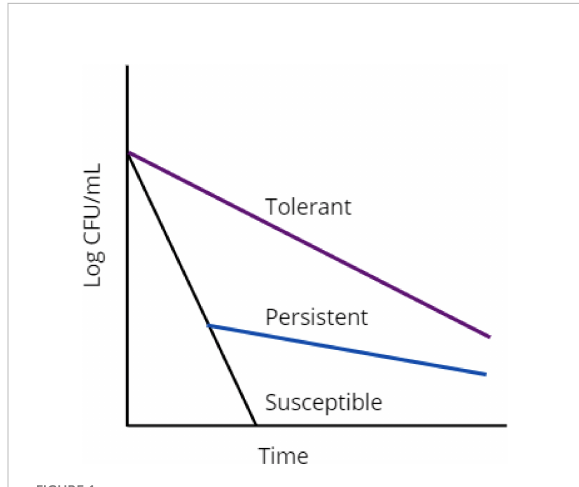
FIGURE 1 Graphical representation of drug susceptible (black), persistent (blue), and tolerant (purple) bacterial